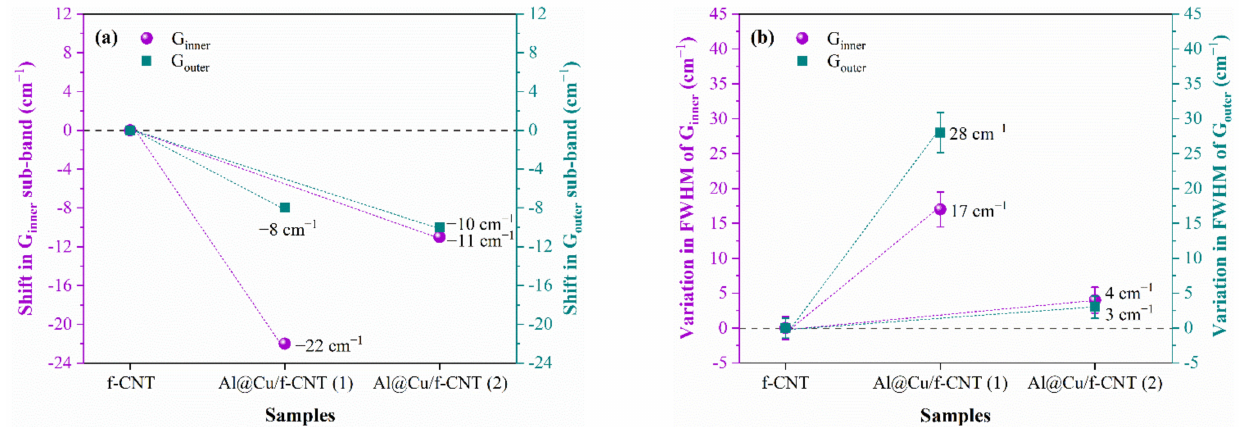
Figure 5. ( a ) Shifts and ( b ) FWHM variations of the G inner and G outer sub-bands of the Al@Cu/f-CNT (1) and Al@Cu/f-CNT (2) samples compared to the f-CNT sample as